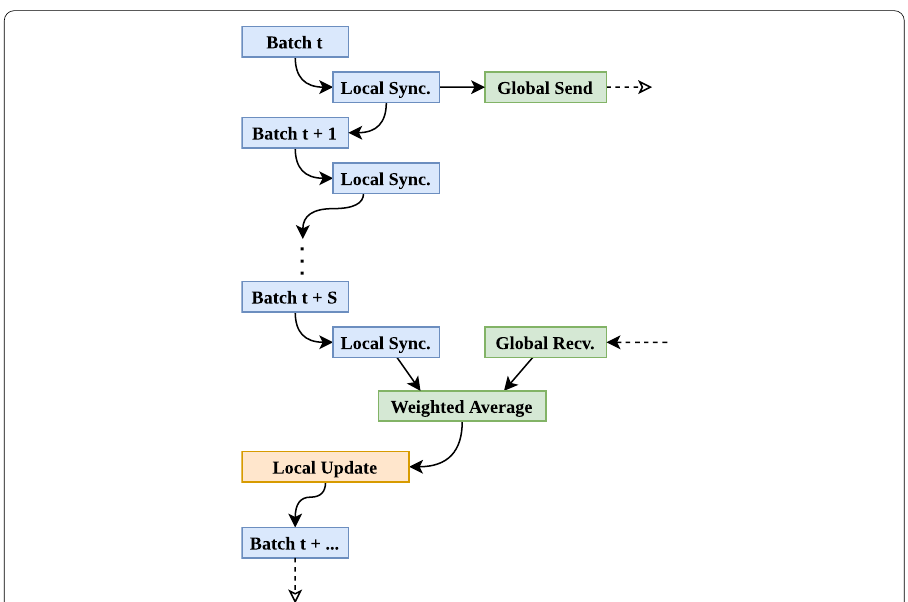
Fig. 5 Cycling Flow Process flow diagram of the synchronization steps during the cycling phase where t is the batch number and S is the batches to wait before global synchronization. The weighted average is calculated as shown in Eq.